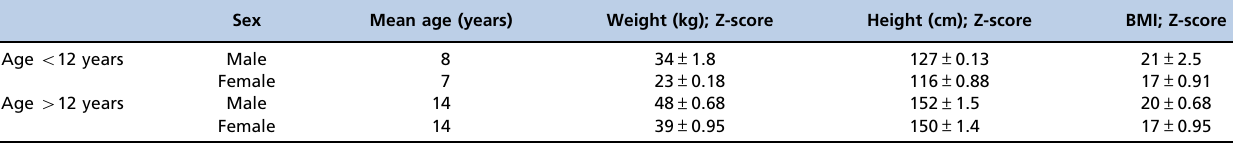
Table 1 - Height and weight mean values, BMI, and SD (Z-score). Sex Weight (kg); Z-score